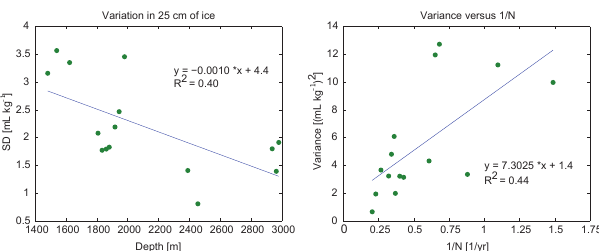
Figure 3. Left: standard deviation of reproducibility measurements in the TAC dependent on depth. Each point represents the mean over five adjacent samples. As expected, the variations get smaller with the smoothing due to thinner annual layers. Right: the variation of the reproducibility measurements vs. 1 /N , where N is the number of annual cycles in the sample.